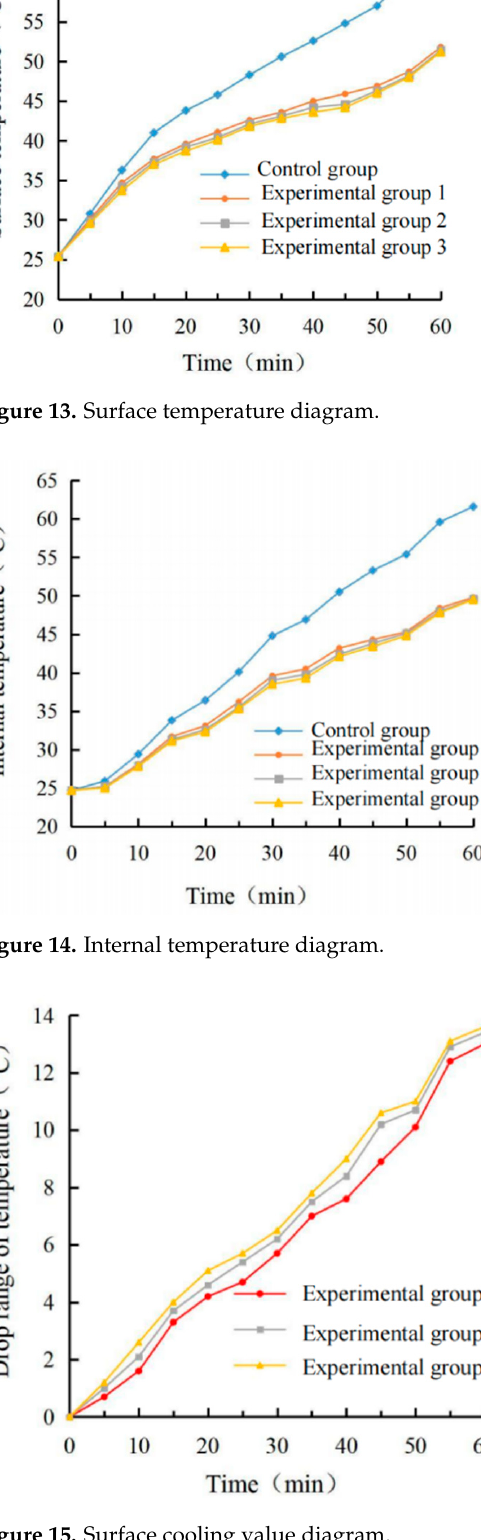
Figure 16. Internal cooling value diagram. 4.2. Evaluation of Outdoor Cooling Effect The real-time temperature diagram and the road surface cooling value diagram are shown in Figures 17 and 18. It can be seen from Figures 17 and 18 that the temperature rise law of the two specimens was basically the same. Still, the temperature of the speci- men with a coating was lower than that of the specimen without coating in each period. The cooling capacity of the thermal reflection coating gradually increased with the in- crease of the ambient temperature. The reason is that the solar radiation reflection and scattering speed that radiates to the coating surface are fast at low ambient temperature,